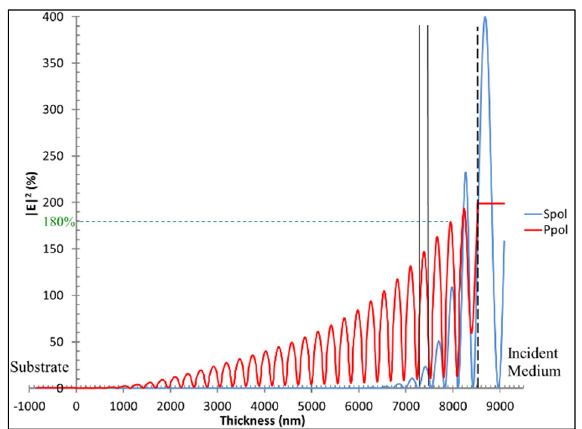
Figure 8. Optical E ‐ field intensities (as % of incident intensity) within the coating for 1000 nm wavelength light at 45° AOI, Spol and Ppol, for the BBHR coating design. The vertical dashed line indicates the boundary of the coating with the incident medium. The two vertical solid lines indicate a TiO 2 coating layer. This figure appeared as the bottom left ‐ hand graph in Figures 6 and 8 of our earlier report [15].